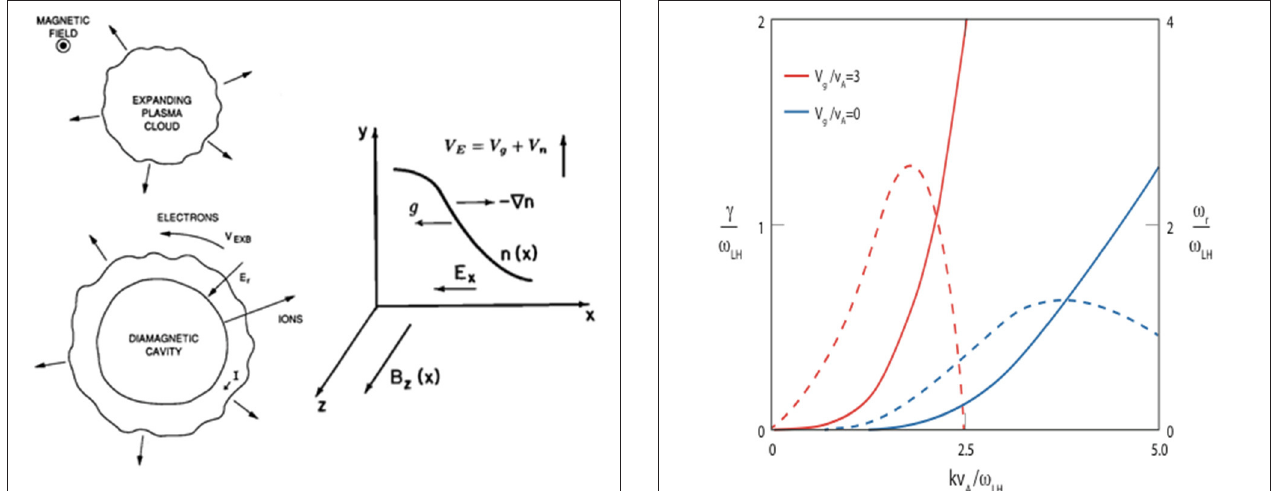
when it comes to rest as the magnetic cavity reaches its maximum